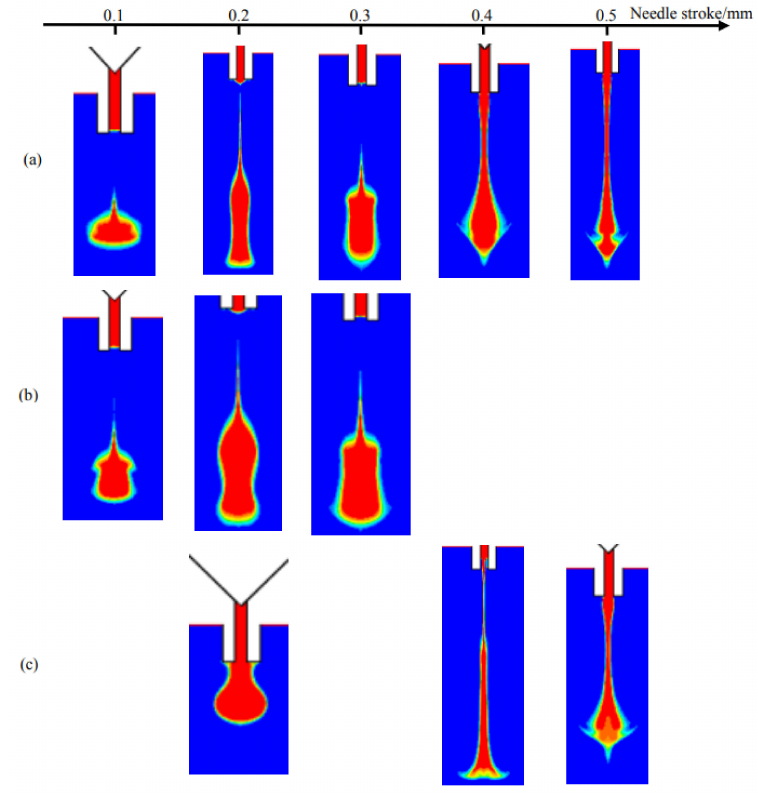
Figure 8. Simulation results from the changes in needle stroke when pressure is ( a ) 0.6 MPa; ( b ) 0.8 MPa; ( c ) 0.3 MPa.